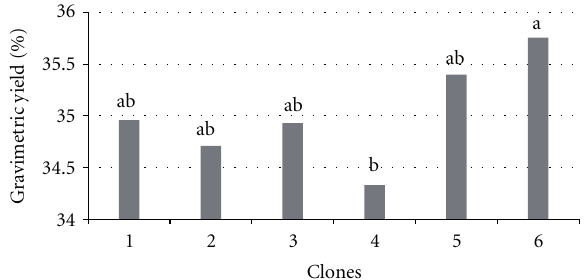
Figure 2: Mean values of wood higher heating value (HHV) of Eucalyptus spp., in MJ · kg − 1 . Standard deviation = 0.19; variation coe ffi cient = 1.0%.